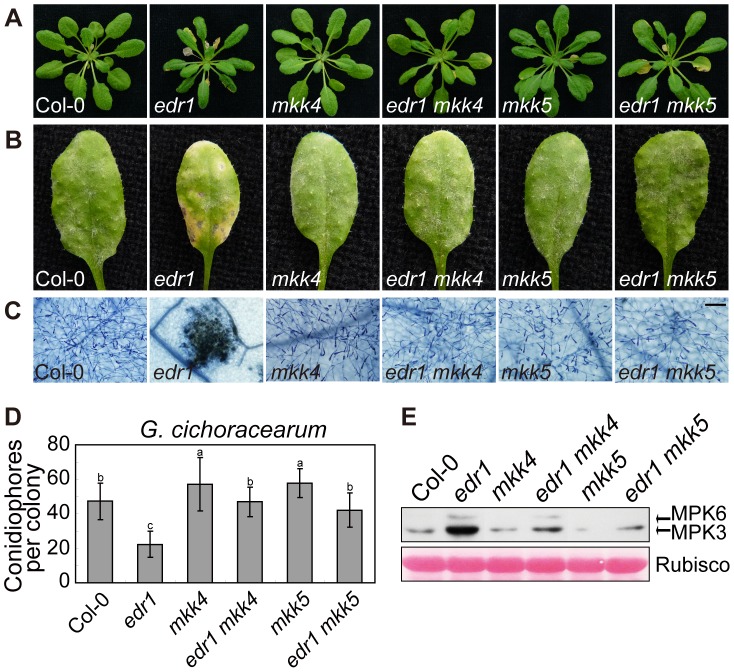

mkk4 and mkk5 suppress edr1-mediated resistance to powdery mildew and cell death.(A) Col-0, edr1, mkk4, edr1 mkk4, mkk5 and edr1 mkk5 were grown in the greenhouse at 22°C and a 9 h light/15 h dark regime. Pictures were taken after 5 weeks of growth. (B) Plants were infected by G. cichoracearum. Pictures were taken at 7 dpi. (C) Powdery mildew infected leaves at 7 dpi were stained by trypan blue. Bar = 0.1 mm. (D) Fungal growth was assessed by counting the number of conidiophores at 5 dpi. At least 30 colonies were counted for each sample. Error bars represent the standard deviation. Different letters represent statistically significant differences (P<0.05, one-way ANOVA). (E) Plants were infected by G. cichoracearum for 3 days. Immunoblot was performed using anti-pTEpY antibody. The large subunit of Rubisco is shown as a protein loading control. The experiment was repeated three times with similar results.